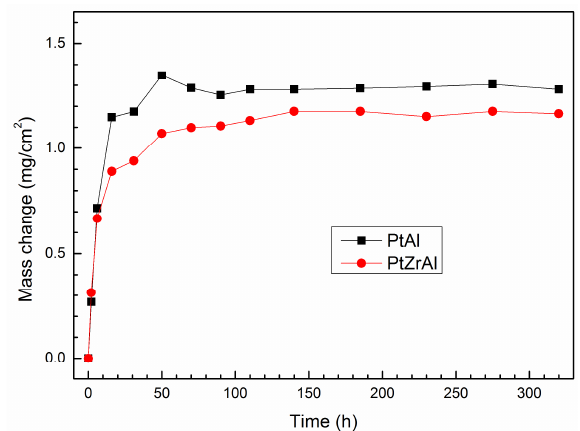
Figure 7. The mass gain versus time of the PtAl and PtZrAl coatings after isothermal oxidation at 1100 °C.